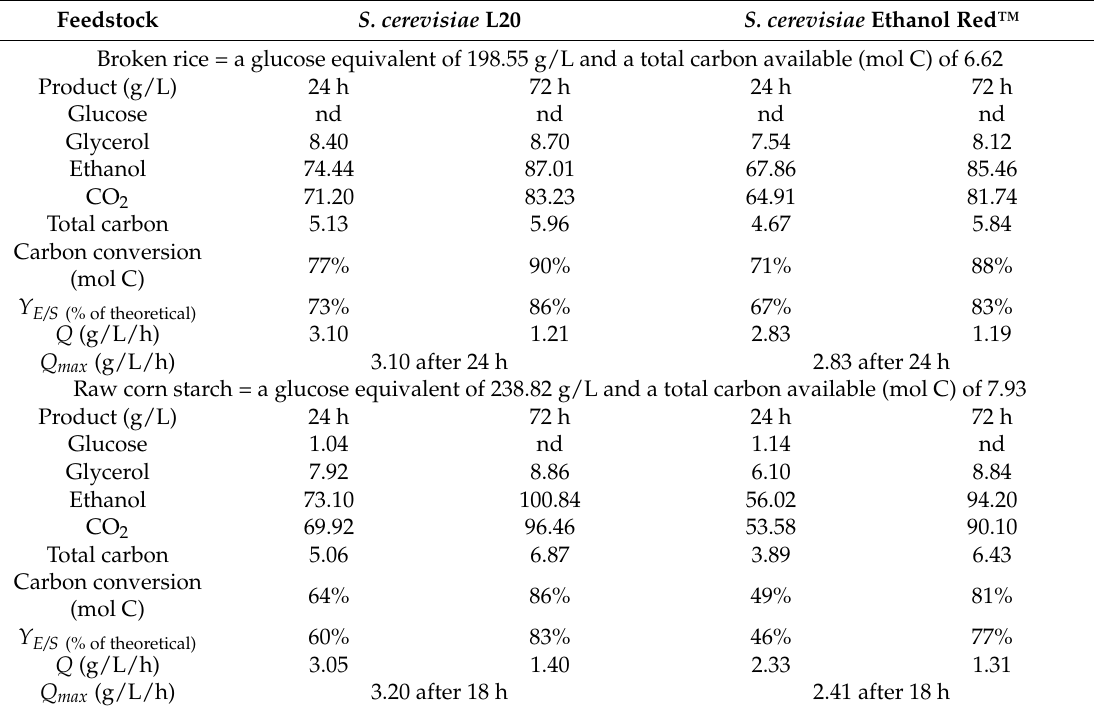
Figure 3. Ethanol, glucose and glycerol production by S. cerevisiae wild-type strains ( a ) L20 and ( b ) Ethanol Red™ during SSF in 1-L bioreactor with 20% (w/v) of broken rice ( ○ ) and raw corn starch (●). The experiment was conducted in duplicate and average values are presented. Table 3. Conversion of starchy substrates at bioreactor level to ethanol and by-products by S. cerevisiae L20 and Ethanol Red™